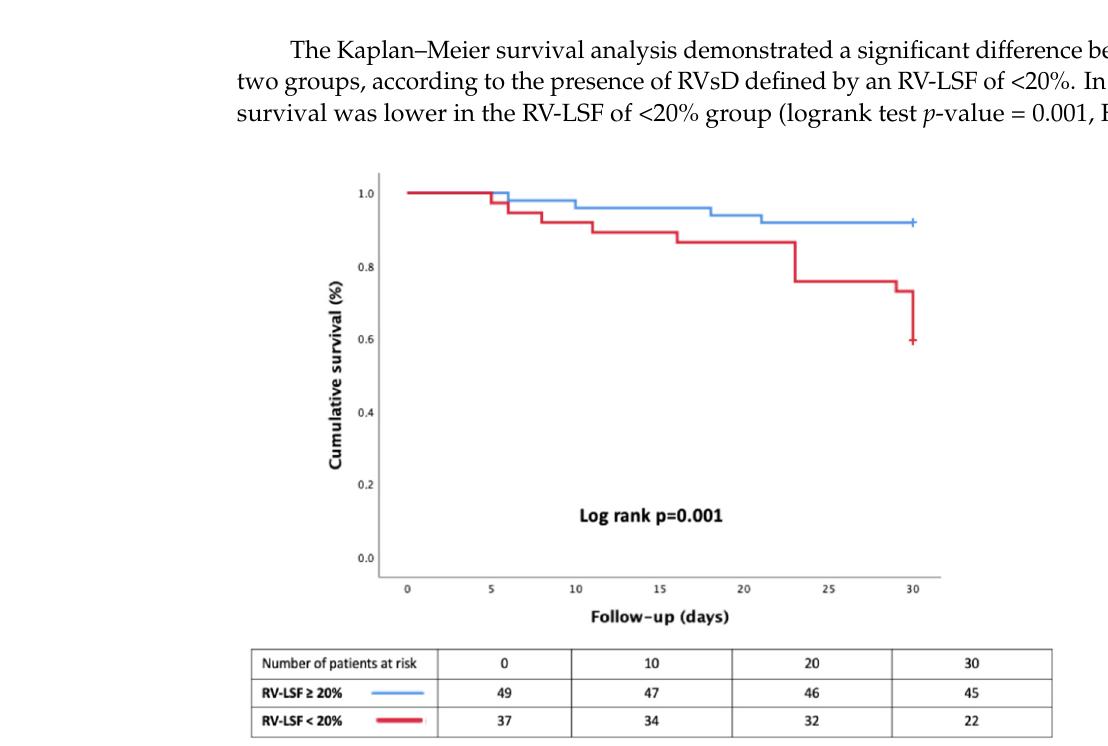
Figure 3 . Kaplan–Meier survival curves, according to the presence of RVsD defined by an RV-LSF of